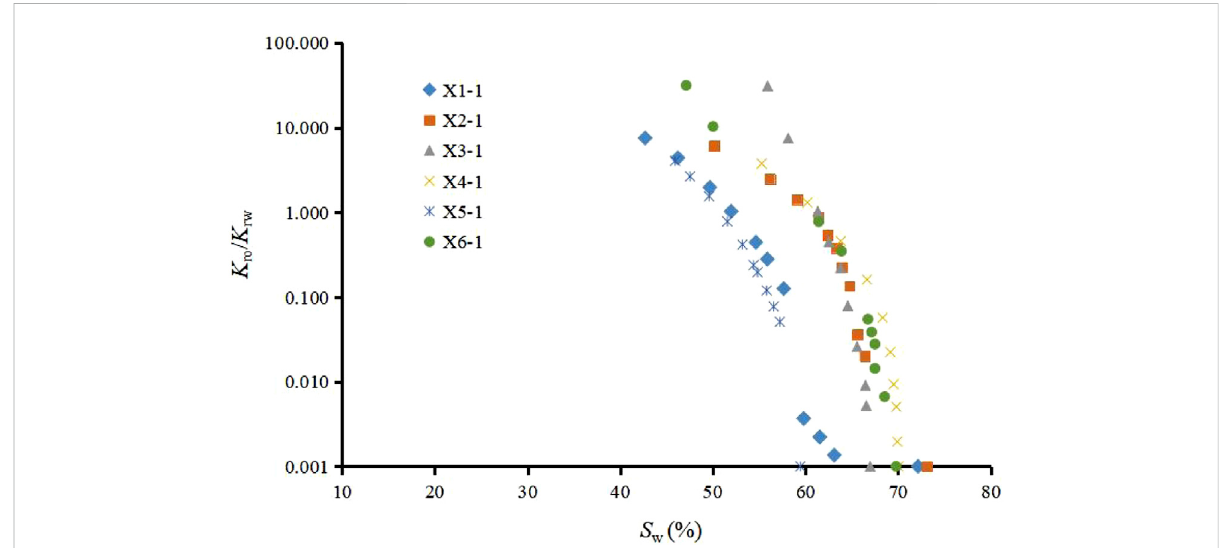
FIGURE 9 Relationship between oil-water relative permeability ratio and S w